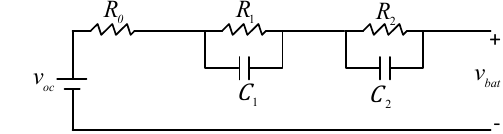
Figure 8. Equivalent electrical circuit (EEC) model of the battery. The parameter values, which represent the battery bank, were obtained for the vented Lead-acid technology. Table 2. Three-phase PWM rectifier requirements and parameters [34].